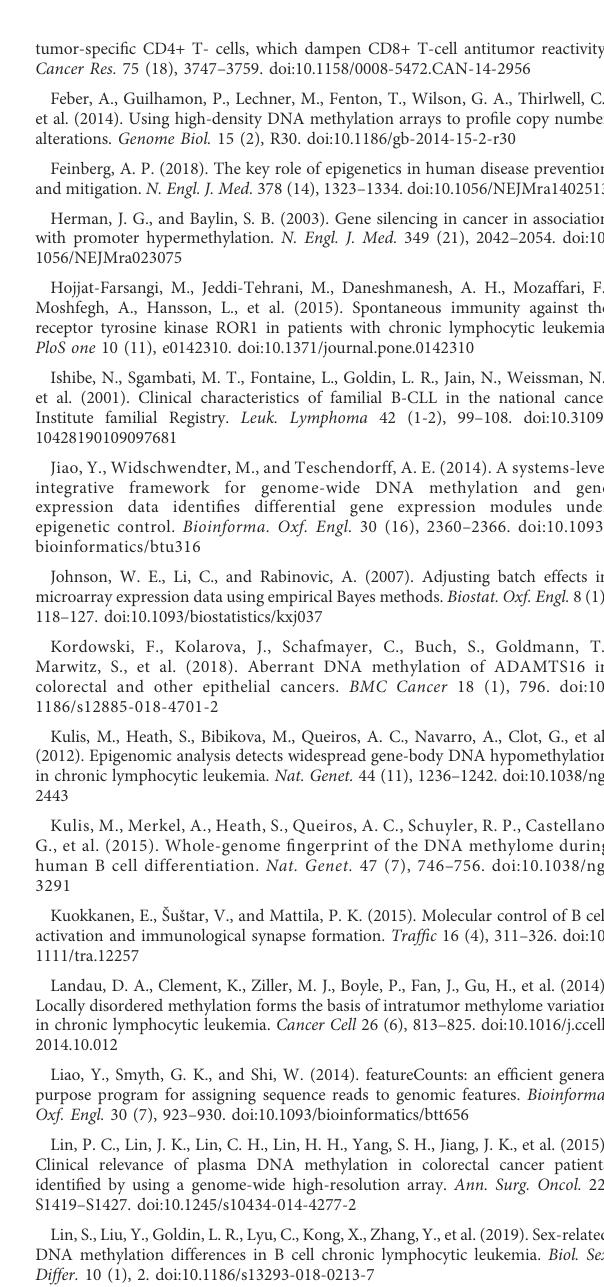
SUPPLEMENTARY TABLE S6 (A) Replicated DMPs (N = 26,244). (B) CLL-related DEGs (N = 5,104). (C) CLL-related DMEGs (N = 1,130).